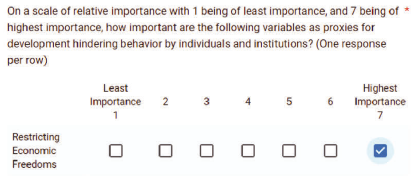
Figure 2: Survey scale and sample